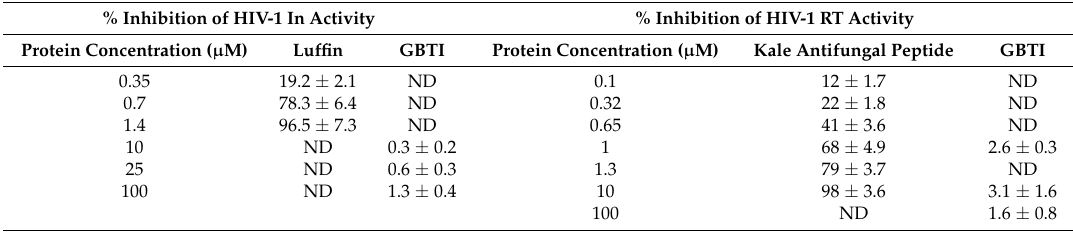
Table 5. Assay of GBTI for inhibitory activity toward HIV–1 integrase (In) and reverse transcriptase (RT). % Inhibition of HIV-1 In Activity